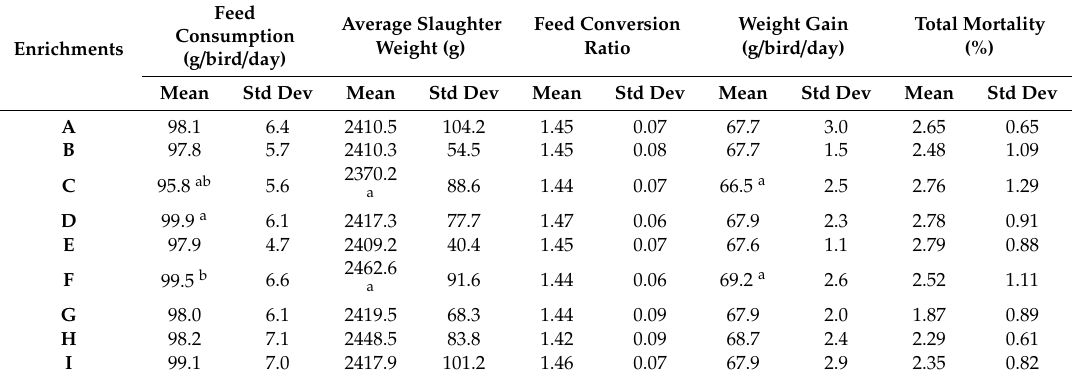
Table 3. Mean ± standard deviation of lifetime average feed consumption, average slaughter weight, feed conversion ratio, lifetime average weight gain and total mortality across